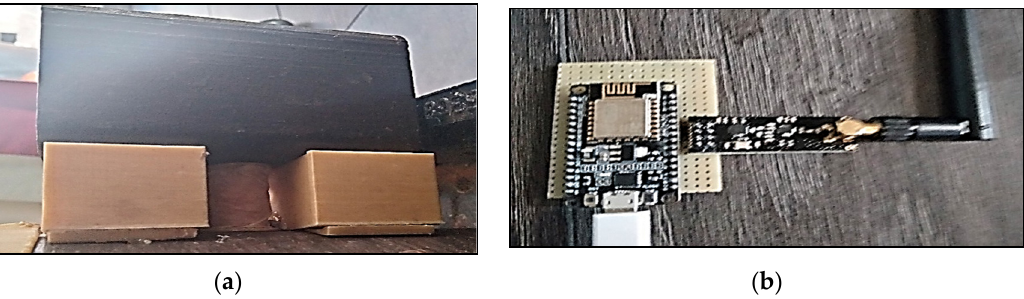
Figure 12. ( a ) The magnetization unit of the MEC sensor, and ( b ) the gateway for communication with the data cloud.